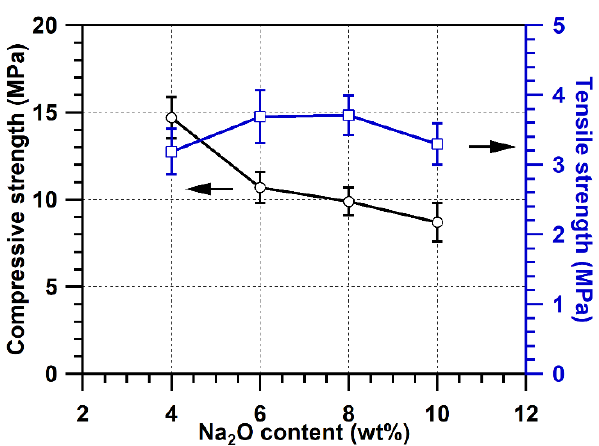
Figure 17. Compressive strength and tensile strength of pervious concrete prepared with various equivalent Na 2 O content at 28 days. equivalent Na 2 O content at 28